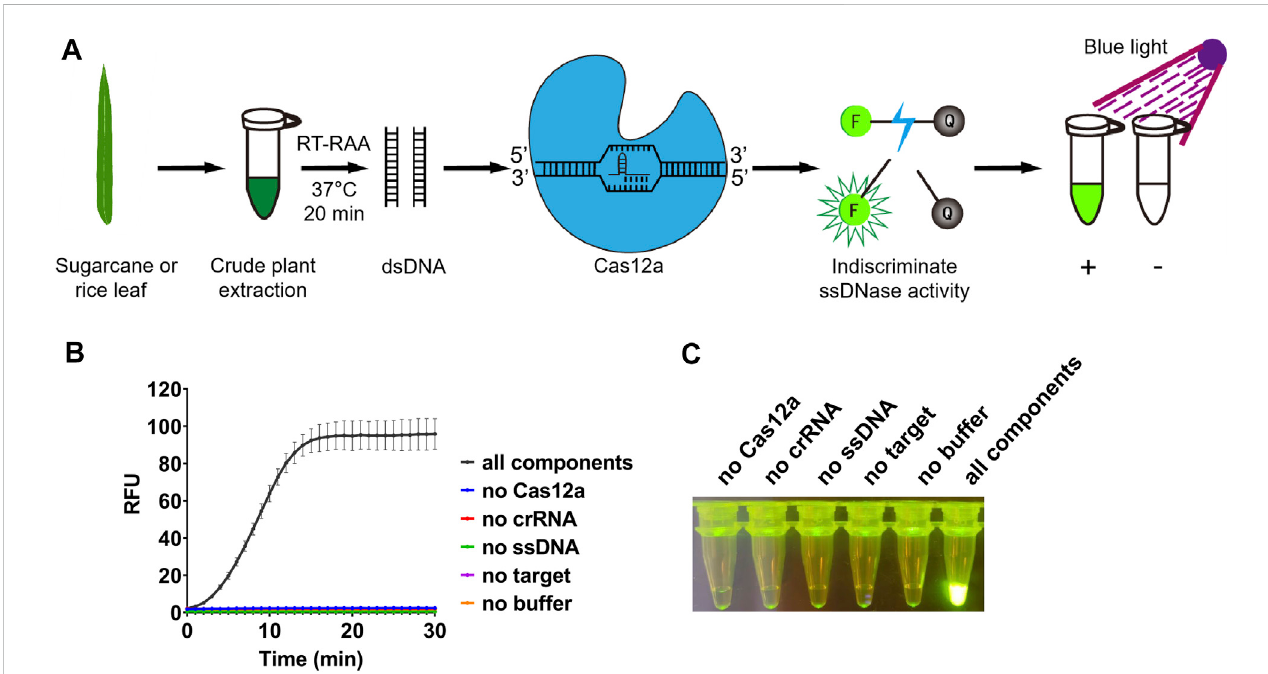
FIGURE 1 Detection system based on reverse transcription-recombinase-aided ampli fi cation and CRISPR/Cas12a. (A) Schematic diagram of the method for rapid andvisualnucleicaciddetectionusingRT-RAA-CRISPR/Cas12aassay.Inthisdetectionsystem,targetgenefragmentswereampli fi edwithRAA;ssDNAprobes (5 ′ -FAM/3 ′ -BHQ1labeled)wereadded,andsubsequentlycleavedbyCas12atogenerategreen fl uorescence.Thedetectionresultsweredirectlyvisibleunder blue light. (B) Validation of the CRISPR/Cas12a assay. In the absence of each component, the real-time fl uorescence signal was continuouslymonitored for 30 min. (C) After 30 min of reaction, the tubes were irradiated with UV light for visualization. n = 3 technical replicates, and data points are shown as mean ± SD.